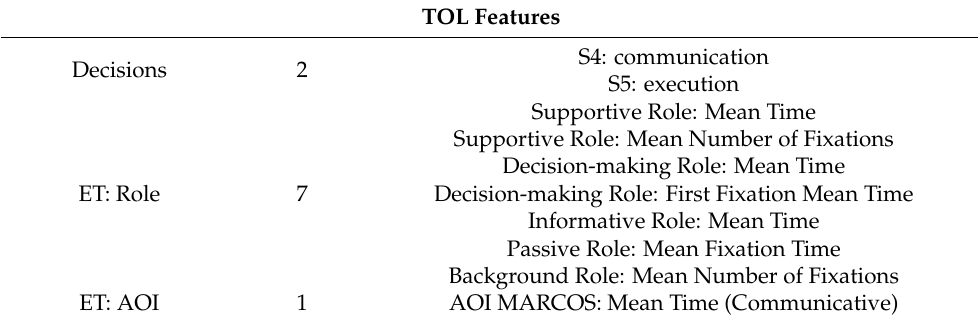
Table 8. TOL feature